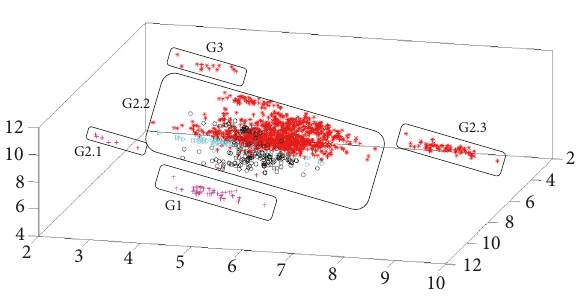
Figure 12: CMLHL 3D visualization + Psychic - Democracy